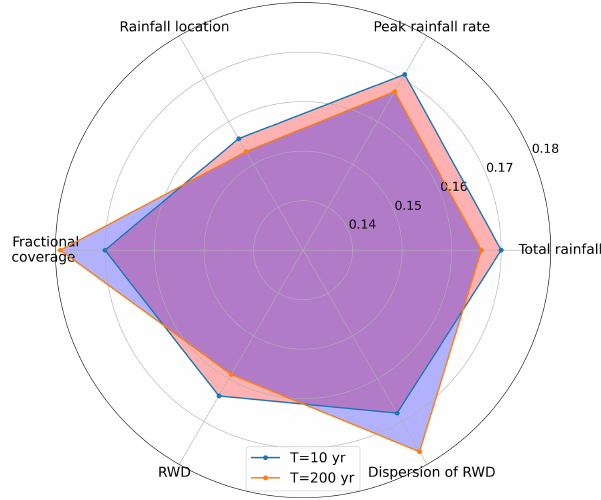
Figure 8. Feature importance analysis of RF model for space–time rainfall structure and 10-year (red) and 200-year (blue) flood peaks.